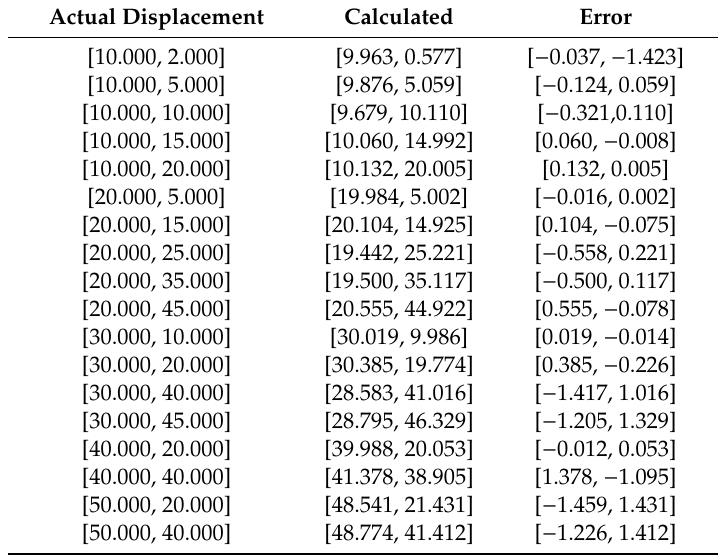
Table 3. Measuring result of [horizontal displacement, vertical displacement] of 10 ◦ tilt angle (unit: